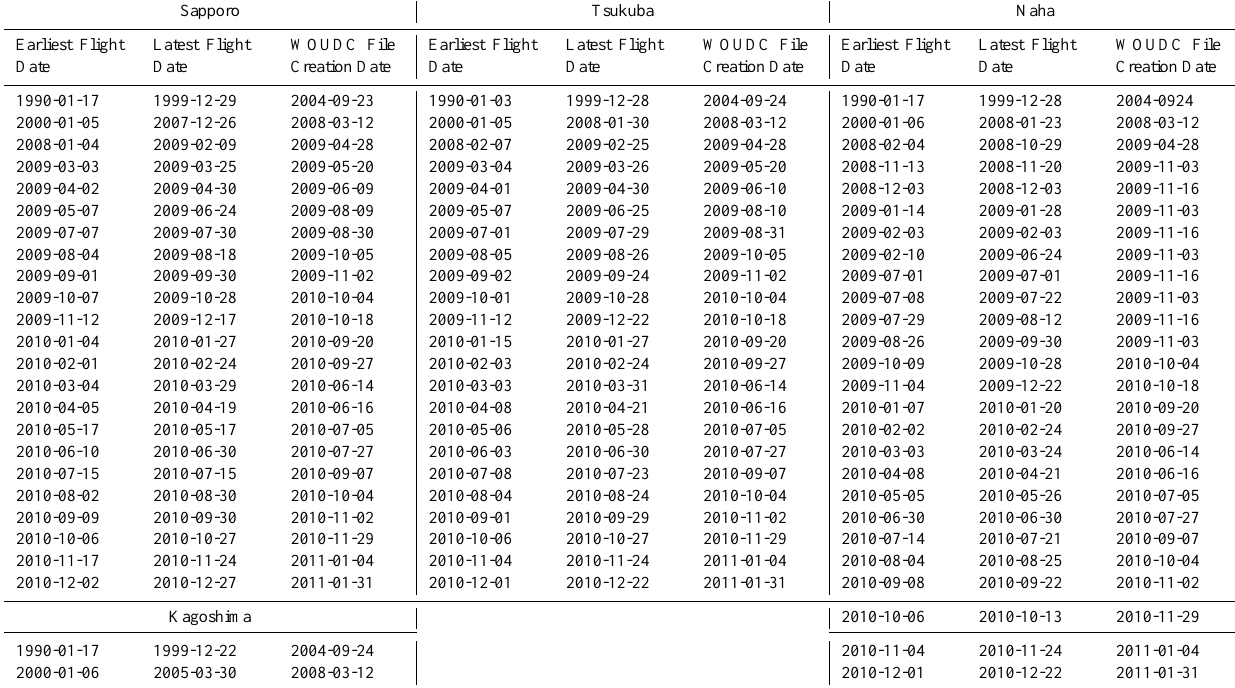
Table 2. Information on the files downloaded from the WOUDC in YYYY-MM-DD format. Ozonesonde data supplied by JMA. Sapporo Tsukuba